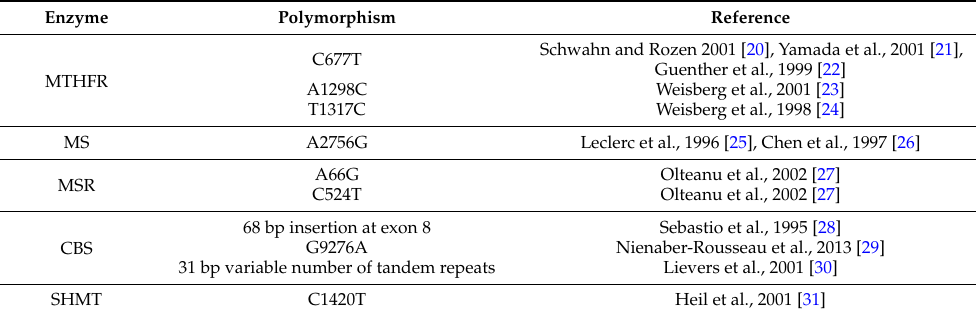
Table 1. Polymorphisms relating to key enzymes in the one-carbon metabolism that are potentially relevant to the development of Alzheimer’s disease